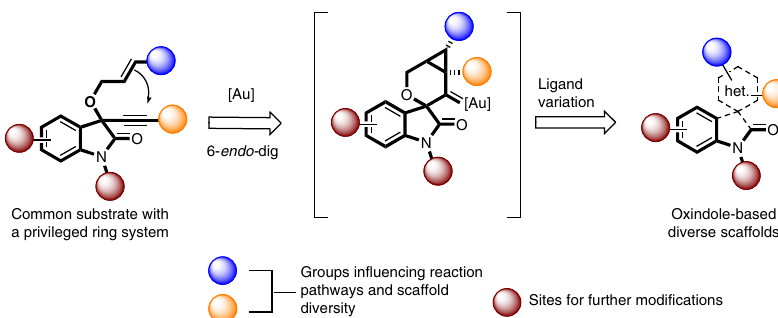
Figure 1 | Design of ligand-directed gold catalysis approach to diverse scaffolds. The approach explores the potential of a common substrate, supporting a privileged oxindole ring system and carrying enyne functional groups that can be influenced differently to follow distinct reaction pathways and thereby generating distinct scaffolds. In particular, ligand variations in the catalytic gold complex can steer the common spirooxindole gold carbene intermediate, formed by gold(I)-mediated 6- endo- dig cycloisomerization, to different rearrangements and leading to diverse scaffolds. Het,